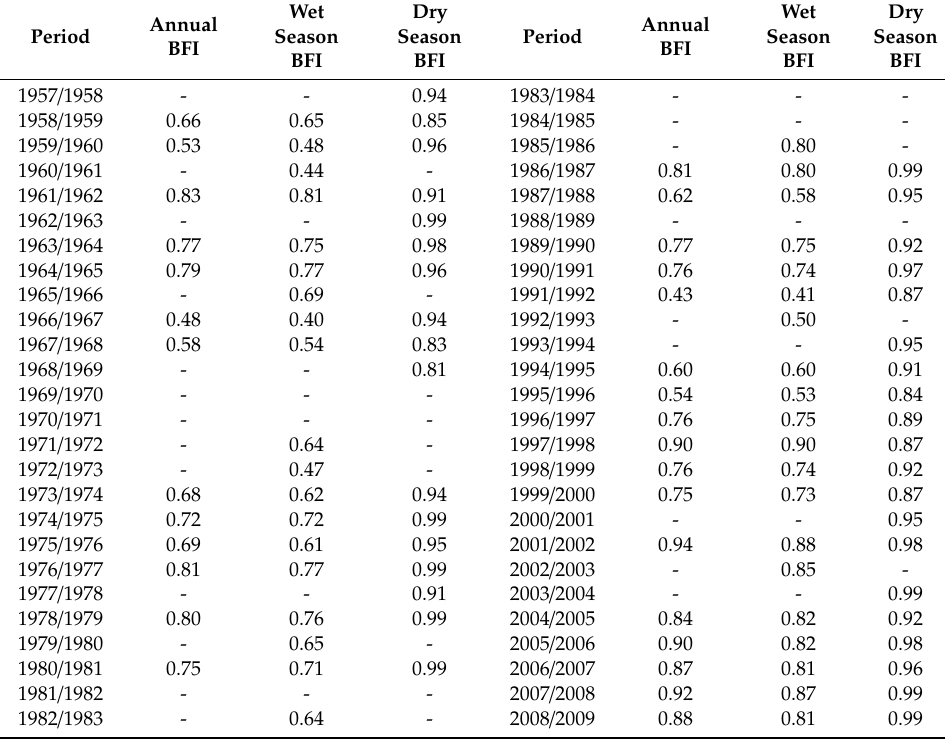
Table 2. Results of the annual and seasonal BFI (base flow index) analysis (tabular) for the Bua River, gauge station 5C1, 1957–2009 (52 years).